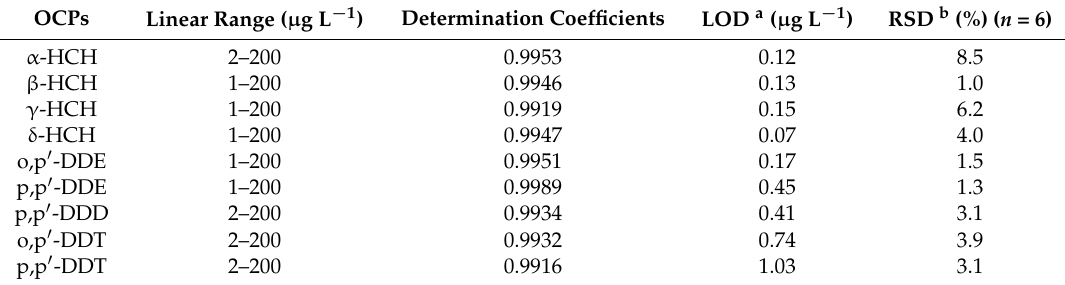
Table 2. Analytical parameters of zeolitic imidazolate framework based on magnetic multiwalled carbon nanotubes as an adsorbent for magnetic solid-phase extraction of nine organochlorine pesticides in an ultrapure water